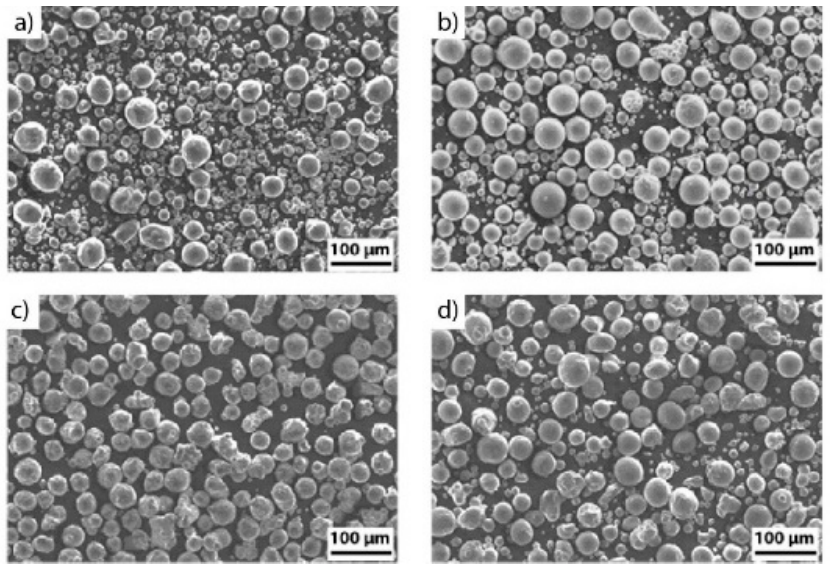
Figure 1. SEM micrographs depicting Fe ( a ), Cr ( b ), Ni ( c ) elemental powders, and mixture of Fe, Cr, and Ni powders ( d ). Table 2. Chemical composition of elemental powders (as specified by the supplier) and LPBF- produced part after in-situ mixing (obtained via ICP-OES). Contents are expressed in wt %. Sample (Bulk or Powder)